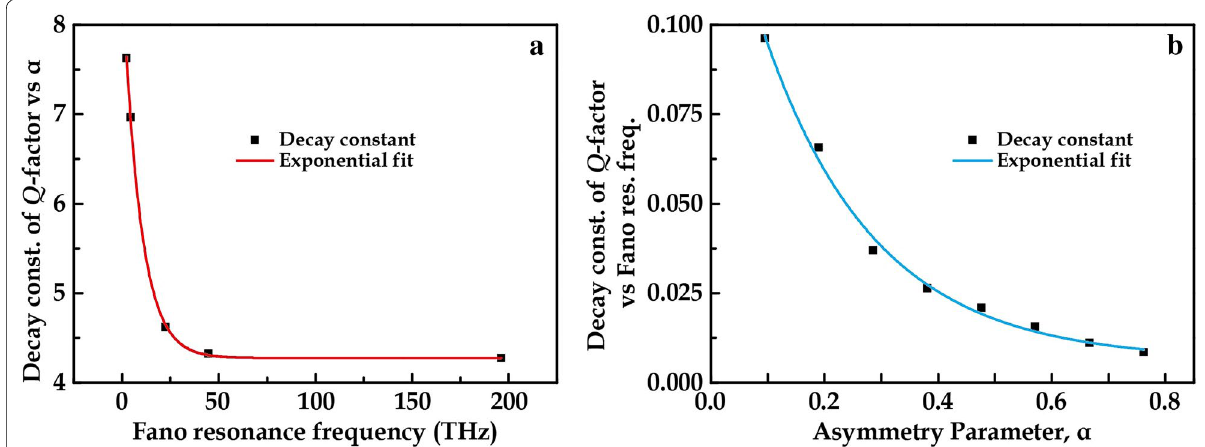
Fig. 6 Decay constants (const.) evaluated from Q -factor against— a asymmetry parameter which is plotted against Fano resonance frequency, and b Fano resonance frequency which is plotted against asymmetry